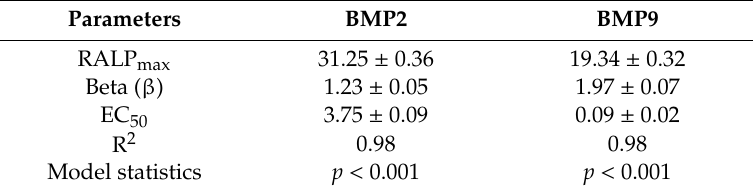
Figure 1. ALP activity measurement relative to control in respect to the number of cells. Dose-response effect of ( A ) BMP9 ( ● ), ( B ) BMP2 ( ○ ) on ALP activity in hmrSCs incubated for 3 days in culture medium containing 10% ( v / v ) FBS and their mathematical modeling ( - ). The results are the mean ± SEM of four independent experiments performed in triplicate. Table 2. Estimated mathematical parameters and modeling statistics ± confidence intervals.